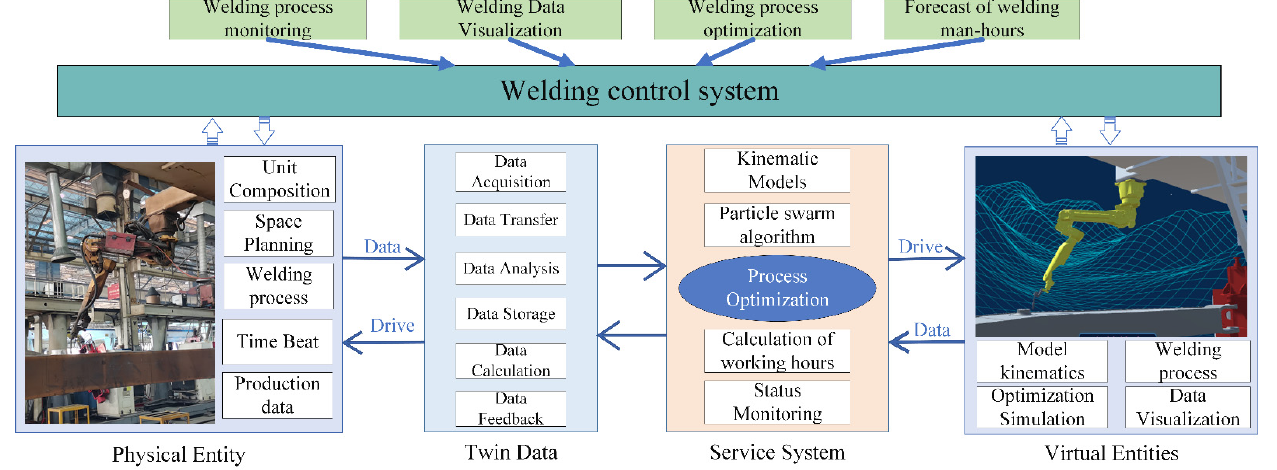
Table 1. Workpiece welding process. Serial No.